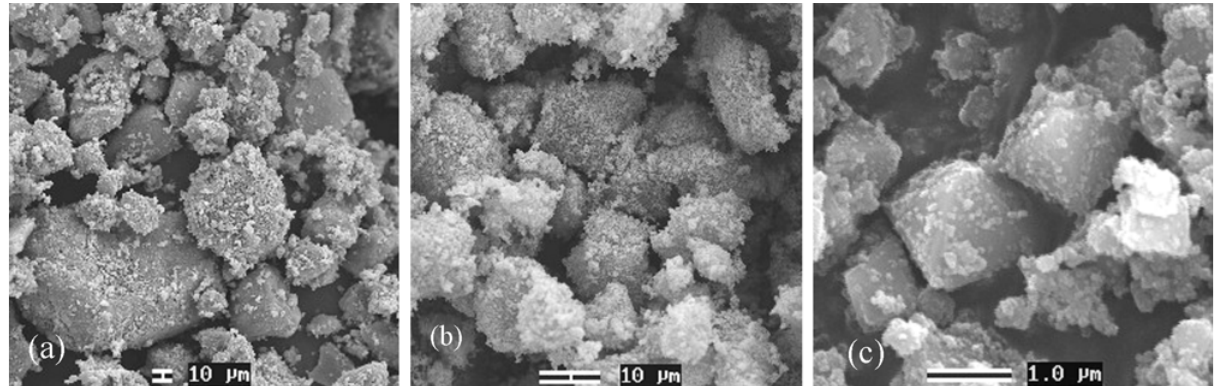
Figure 1. Scanning electron micrograph of the (a) Fe